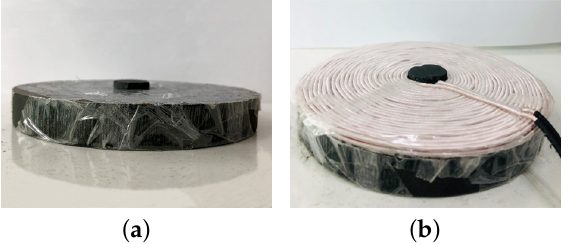
Figure 12. Prototype of the proposed core: ( a ) Prototype of the single proposed core; ( b ) Prototype of the proposed core with coil.